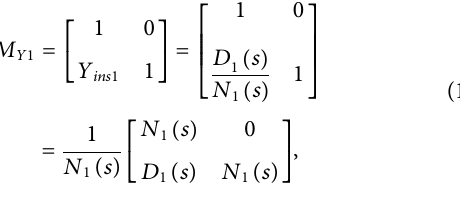
Frontiers in Physics |